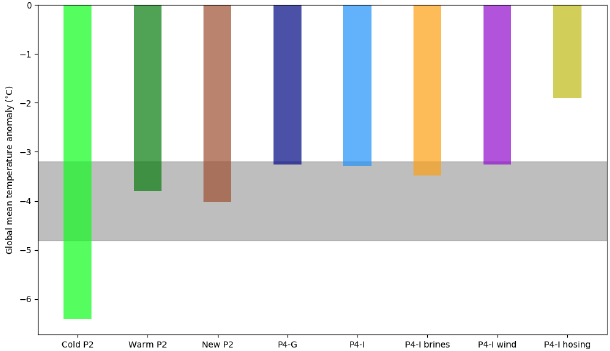
Figure 1. Global mean surface air temperature anomalies (LGM – PI). The gray bar shows the anomaly ( − 4 ± 0 . 8 ◦ C) estimated by Annan and Hargreaves